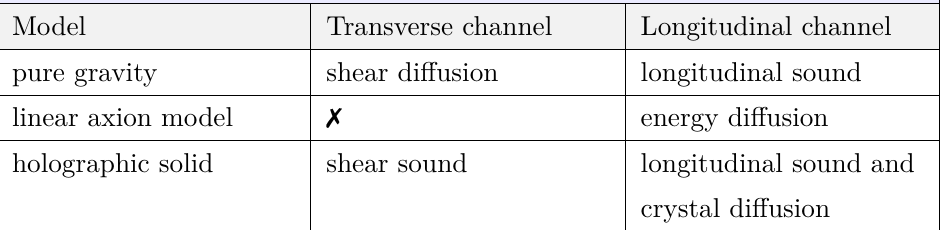
Table 1 . Hydrodynamic (gapless) excitations that exhibited by the models considered in this work: the pure Einstein gravity theory with a Schwarzschild black brane solution, the linear axion model with explicitly broken translations and the holographic solid model with spontaneously broken translations. The symbol 7 indicates the absence of hydrodynamic modes in the particular